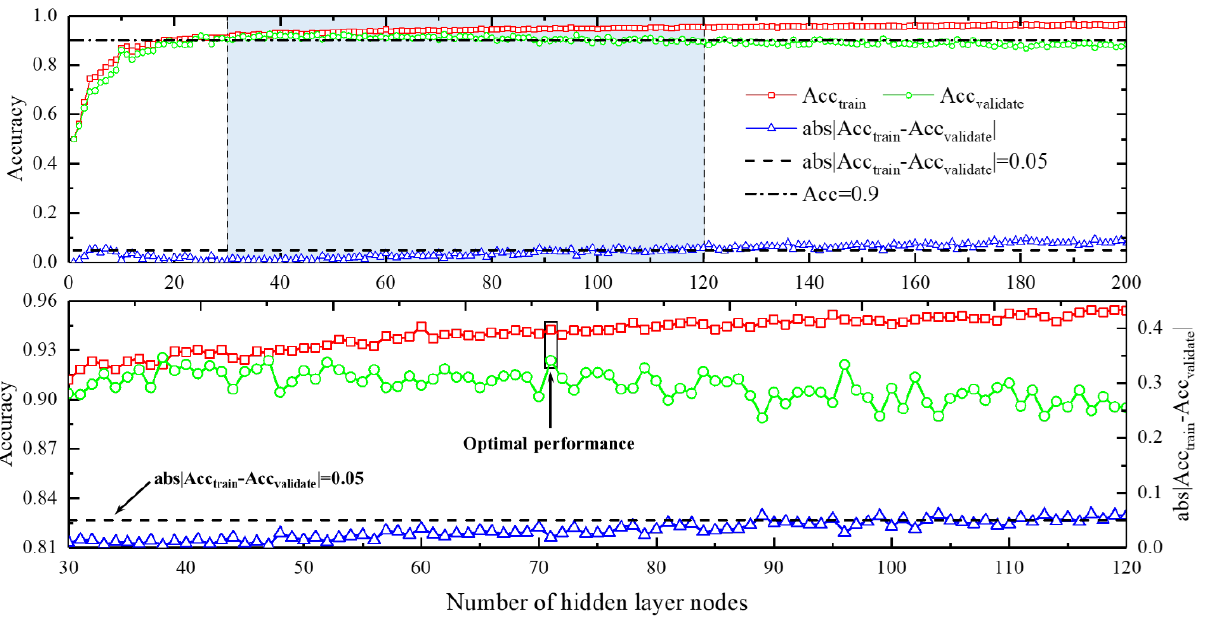
Figure 8. Prediction results of the ELM model with various HLNs.